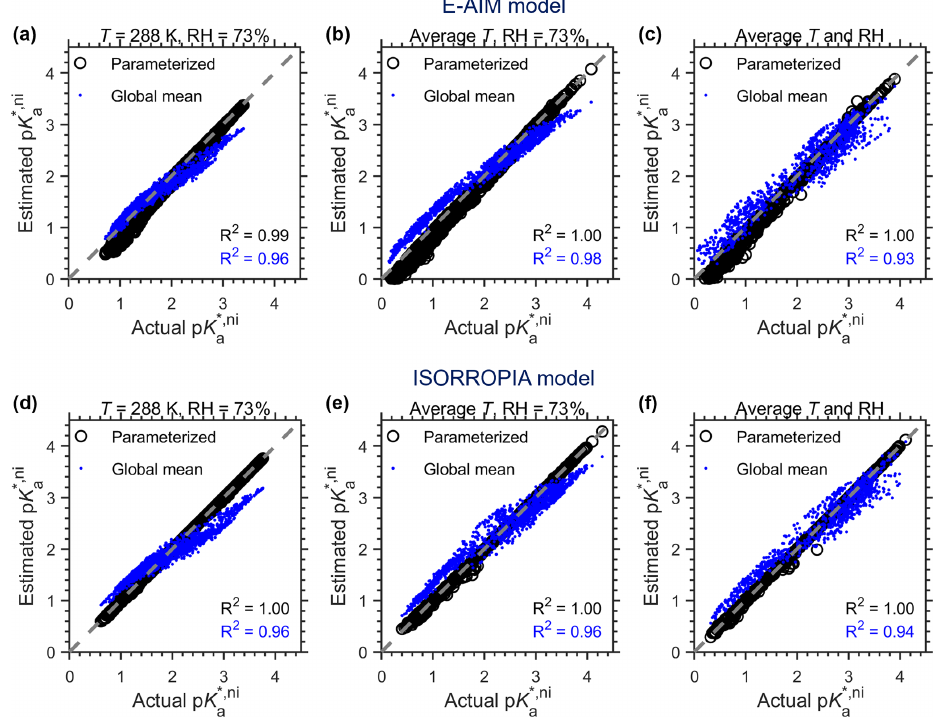
based on the GEOS-Chem global simulations in 2016. Predications are based on (a–b) Figure 5. Comparison of actual and estimated p K ∗ a , ni the E-AIM model and (c–d) the ISORROPIA model. The “parameterized” series are based on the parameterization method proposed in this study, while the global means are based on mean c ni calculated from thermodynamic models under each